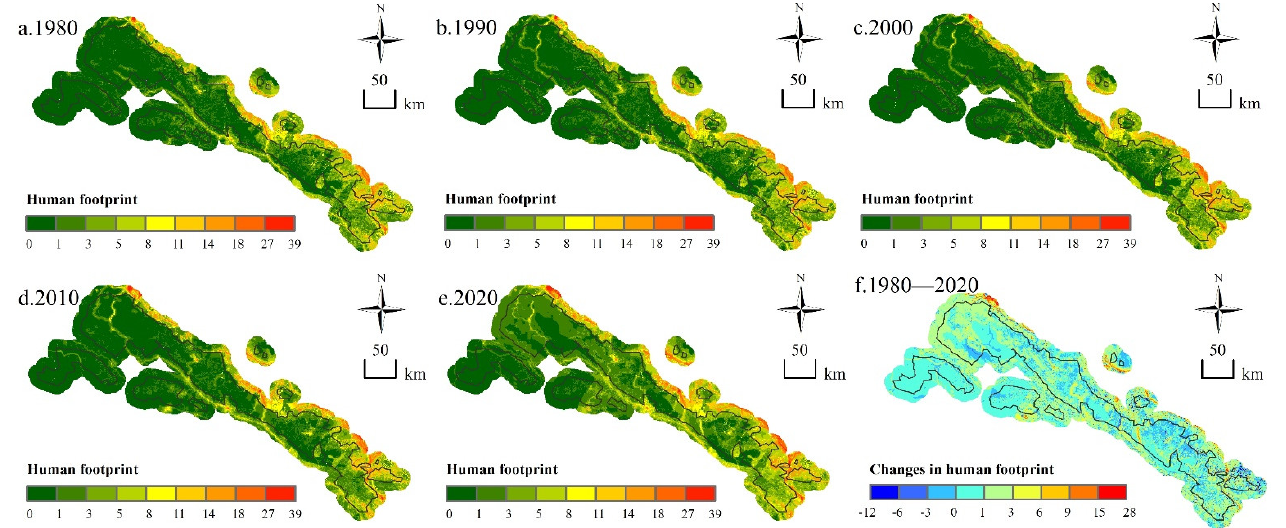
Figure 3. Spatial distribution of human footprint inside and outside of the Qilian Mountain Nature Reserve for 1980–2020.